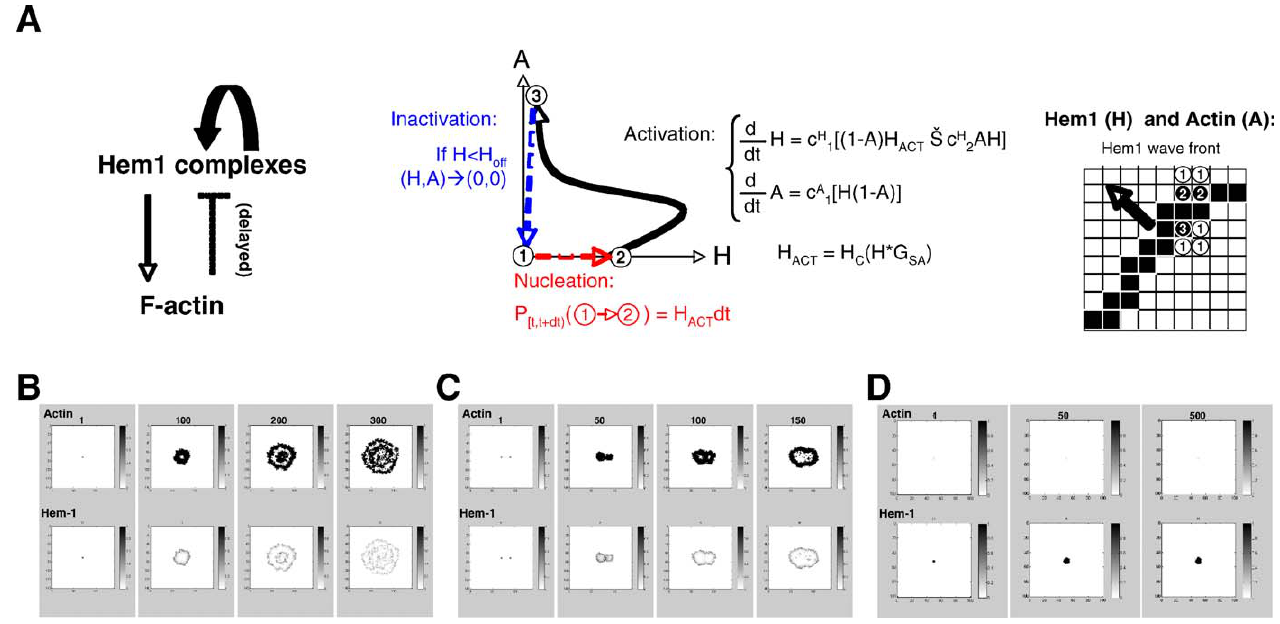
Figure 6. Simulations of Hem-1 Wave Generator (A) Outline of biological model and mathematical simulations. The Hem-1 wave circuit is wired similarly to other biological waves such as action potentials and relies on autoactivation (Hem-1 recruitment adjacent to existing Hem-1 distributions, which is observed 99% 6 1% of the time in living cells) and delayed inhibition (actin polymers inhibiting Hem-1 membrane association). Membrane-associated Hem-1 locally generates actin polymers via the WAVE2 complex, and more Hem-1 is recruited. After a delay, actin polymers locally remove Hem-1 from the membrane. The process repeats until old actin polymers are ultimately broken down, and the process continues. The lifetime of the actin polymers dictates the length of the gaps between waves. The Matlab code used for Figure 6 is presented in Protocol S1. Our mathematical simulations are based on the parameters listed in Table 1. (B) Simulations of polarity circuit in Figure 6A (Video S19). Combining reciprocal interactions of Hem-1 waves and actin produces Hem-1 waves that lead actin assembly and move with a characteristic gap between waves (roughly corresponding with lifetime of actin polymer). The top panel represents actin polymer, and the bottom panel represents membrane-associated Hem-1. (C) Simulation of colliding waves based on model in Figure 6A (Video S20). The top panel represents actin polymer, and the bottom panel represents membrane-associated Hem-1. Colliding waves annihilate. Compare with colliding Hem-1 waves in living cell Figure 3E and Video S13. (D) Actin depolymerization freezes waves in simulations. The simulation is based on model in Figure 6A (Video S21). Depolymerization of the actin 0) freezes Hem-1 waves and increases their intensity, mirroring the behavior of living cells (compare with Figure 4A, Videos cytoskeleton (by setting c A 1 ¼ S15 and S16). The top panel represents actin polymer, and the bottom panel represents membrane-associated Hem-1.